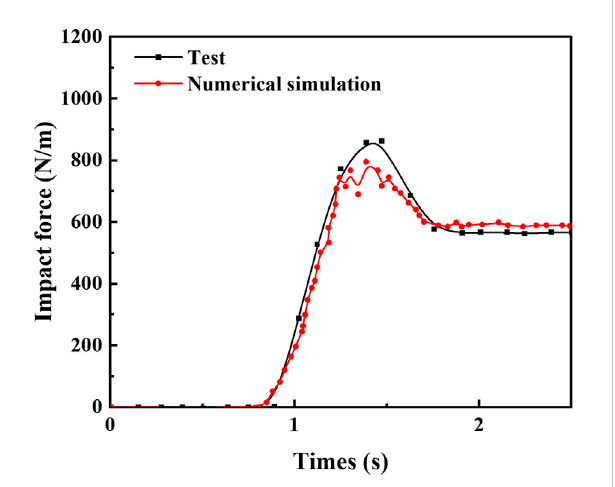
FIGURE 7 Comparison of the time history curves of the indoor test and numerical simulation impact force.